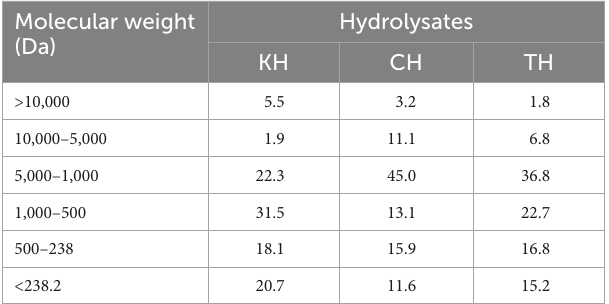
TABLE 2 Molecular weight (%) of kingfish hydrolysate (KH), carp hydrolysate (CH), and tuna hydrolysate (TH)